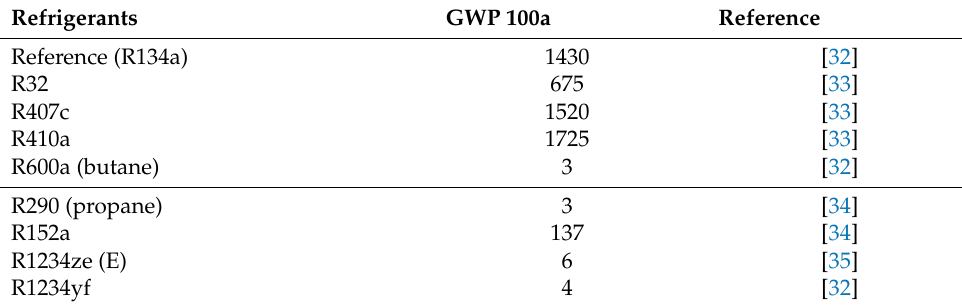
Table 11. GWP 100a of the selected refrigerant for the parametric study.